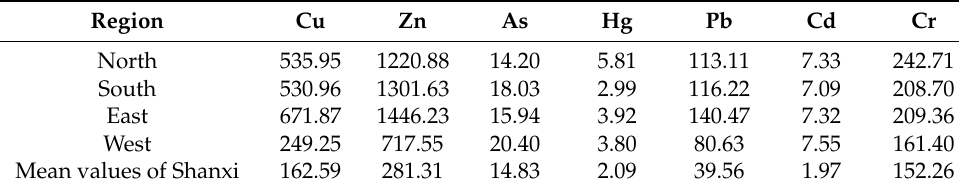
Table 4. HM contents in different regions of China